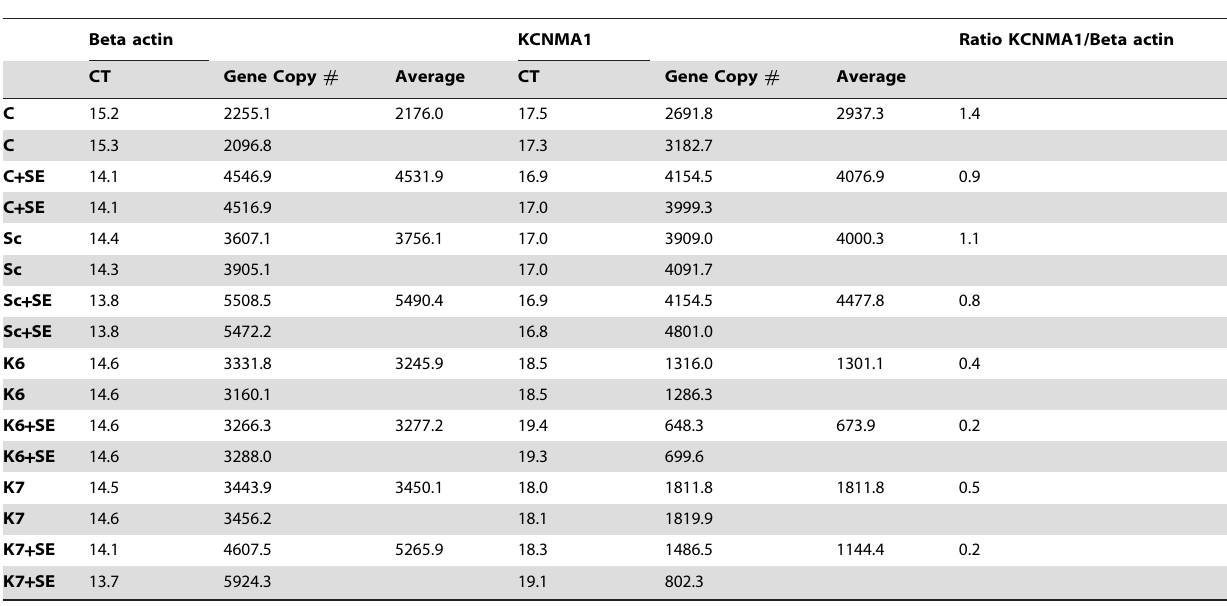
Table 3. qRT-PCR results for KCNMA1 knock